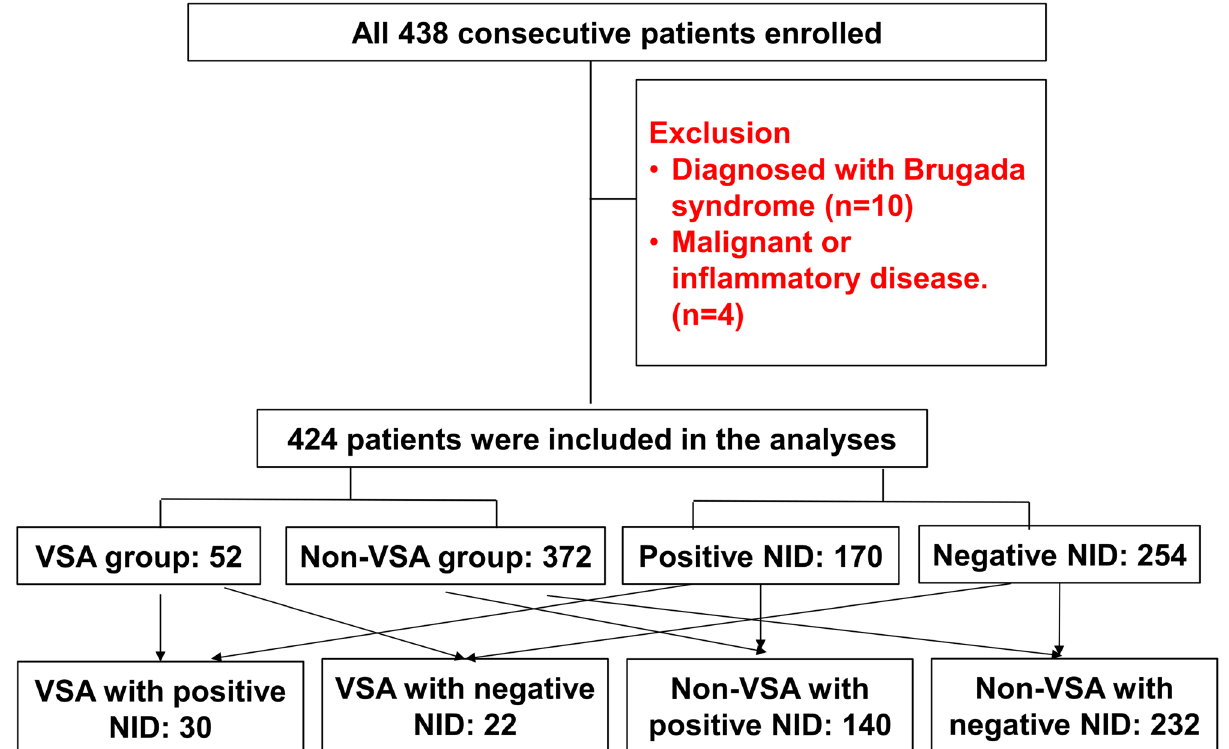
Figure 1. Study flow. Abbreviations: VSA vasospastic angina, NID nitroglycerin induced